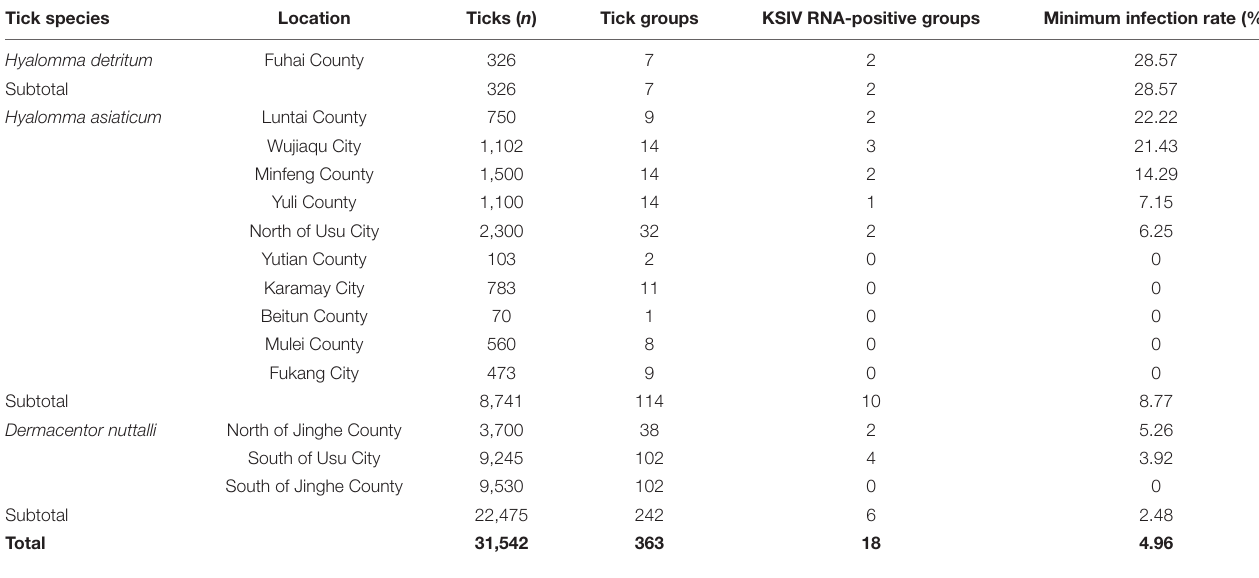
TABLE 1 | Prevalence of Karshi virus (KSIV) among groups of Hyalomma detritum , Hyalomma asiaticum , and Dermacentor nuttali ticks collected from vegetation in Xinjiang. Tick species Location Ticks ( n ) Tick groups KSIV RNA-positive